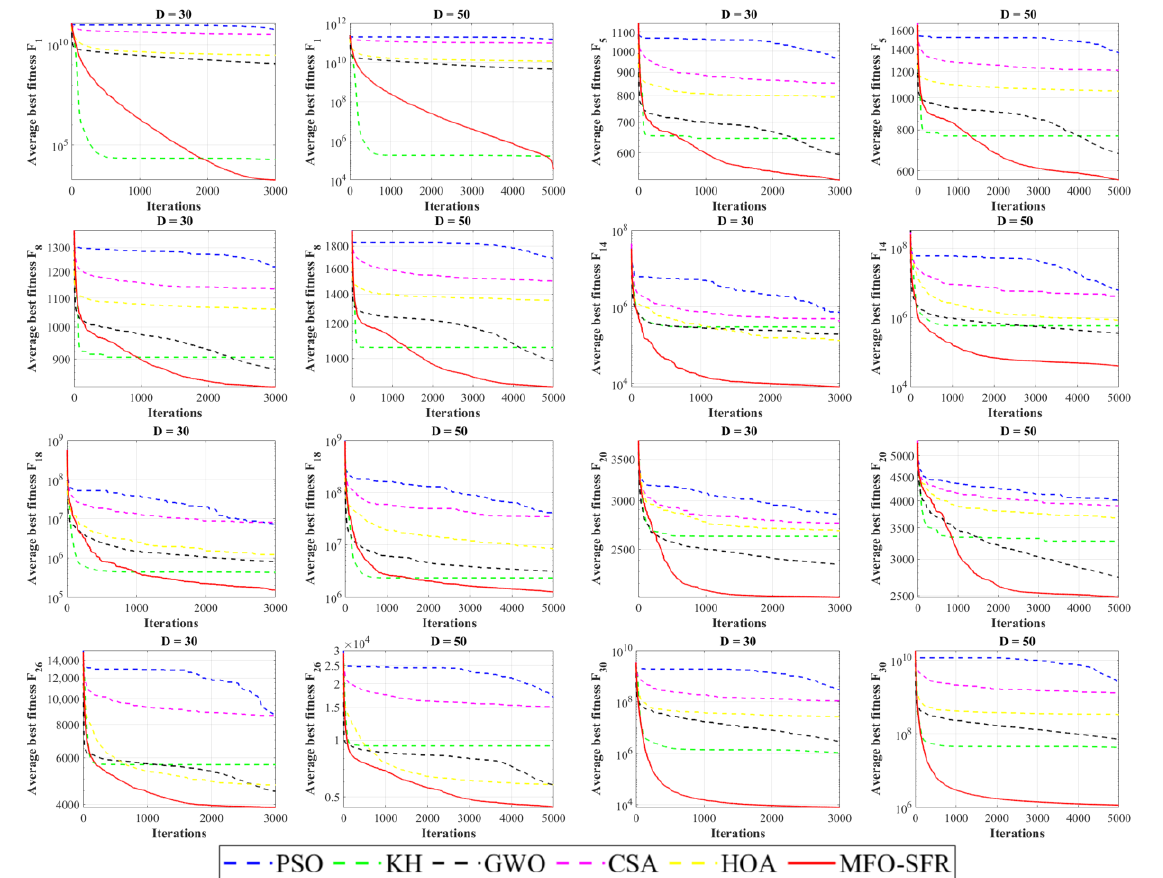
Figure 3. Exploratory data analysis of MFO-SFR and other well-known MFO algorithms on CEC 2018 with 30 and 50 dimensions.